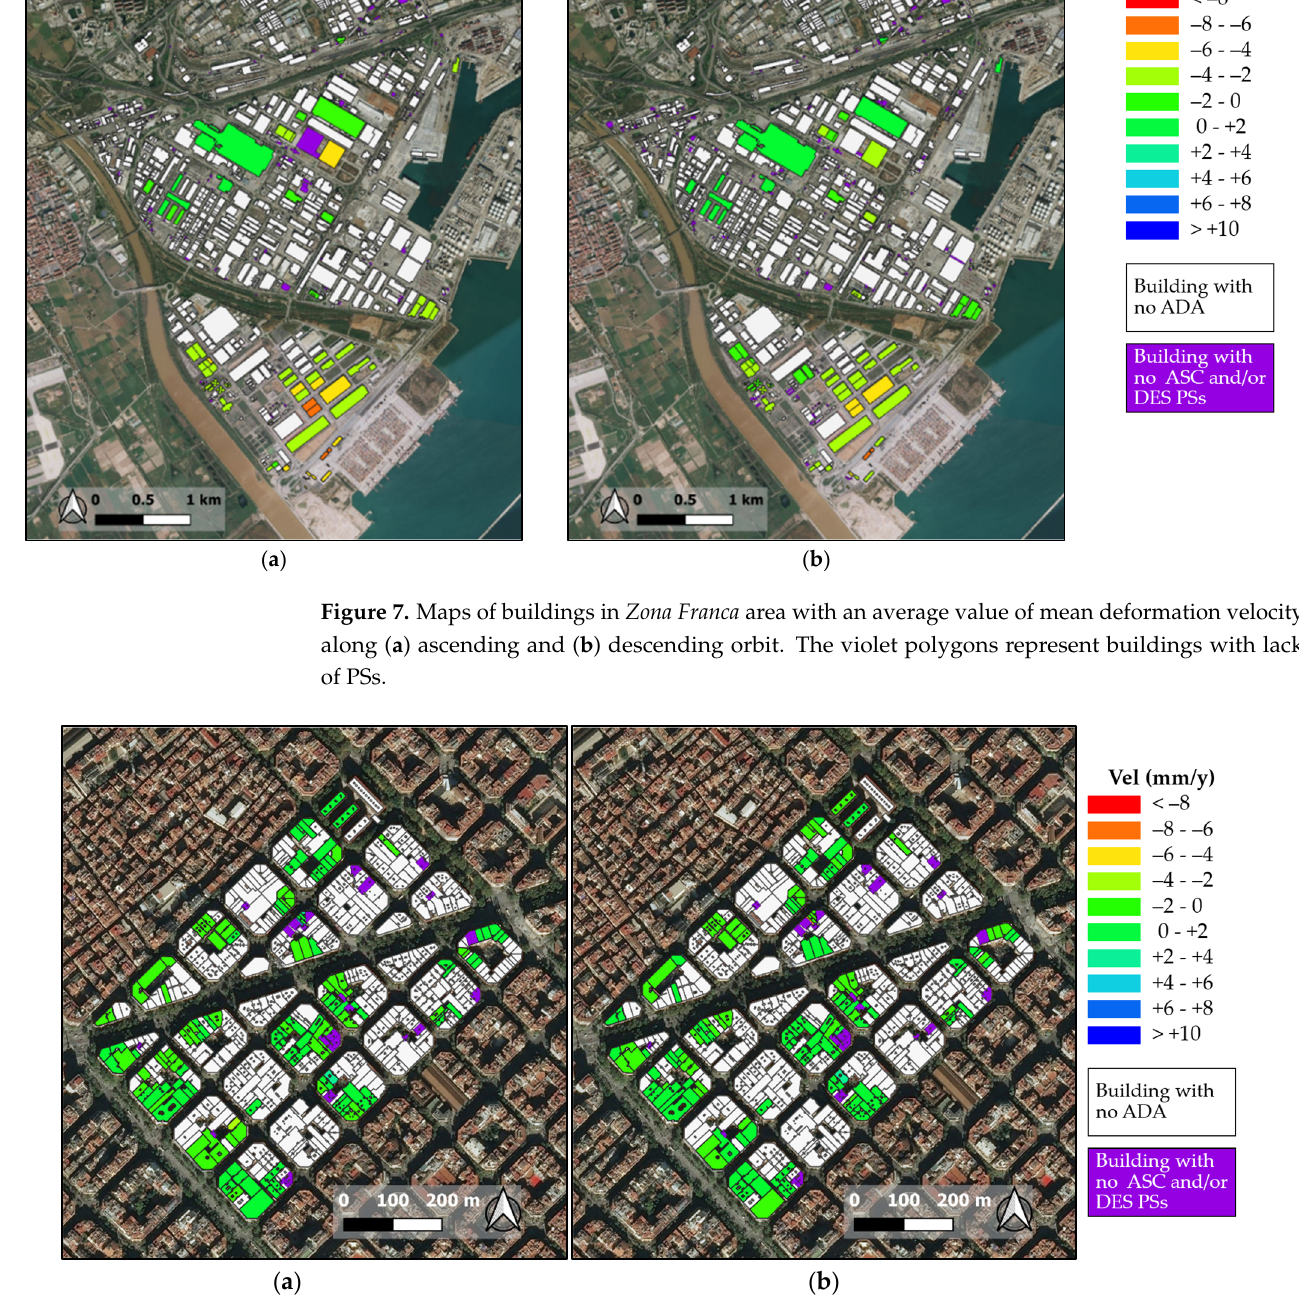
Figure 8. Maps of ( a ) V EW and ( b ) V V components for the “unstable” buildings in Eixample area. The violet polygons represent buildings with original lack of PSs.